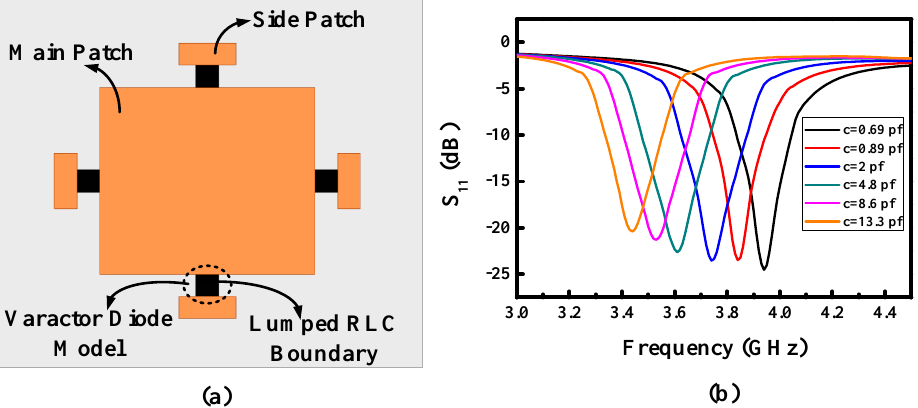
Figure 2. ( a ). Details of the simulation model (four smaller patches are all connected to the larger main patch). ( b ). The return losses at different frequencies for the reconfigurable antenna array.